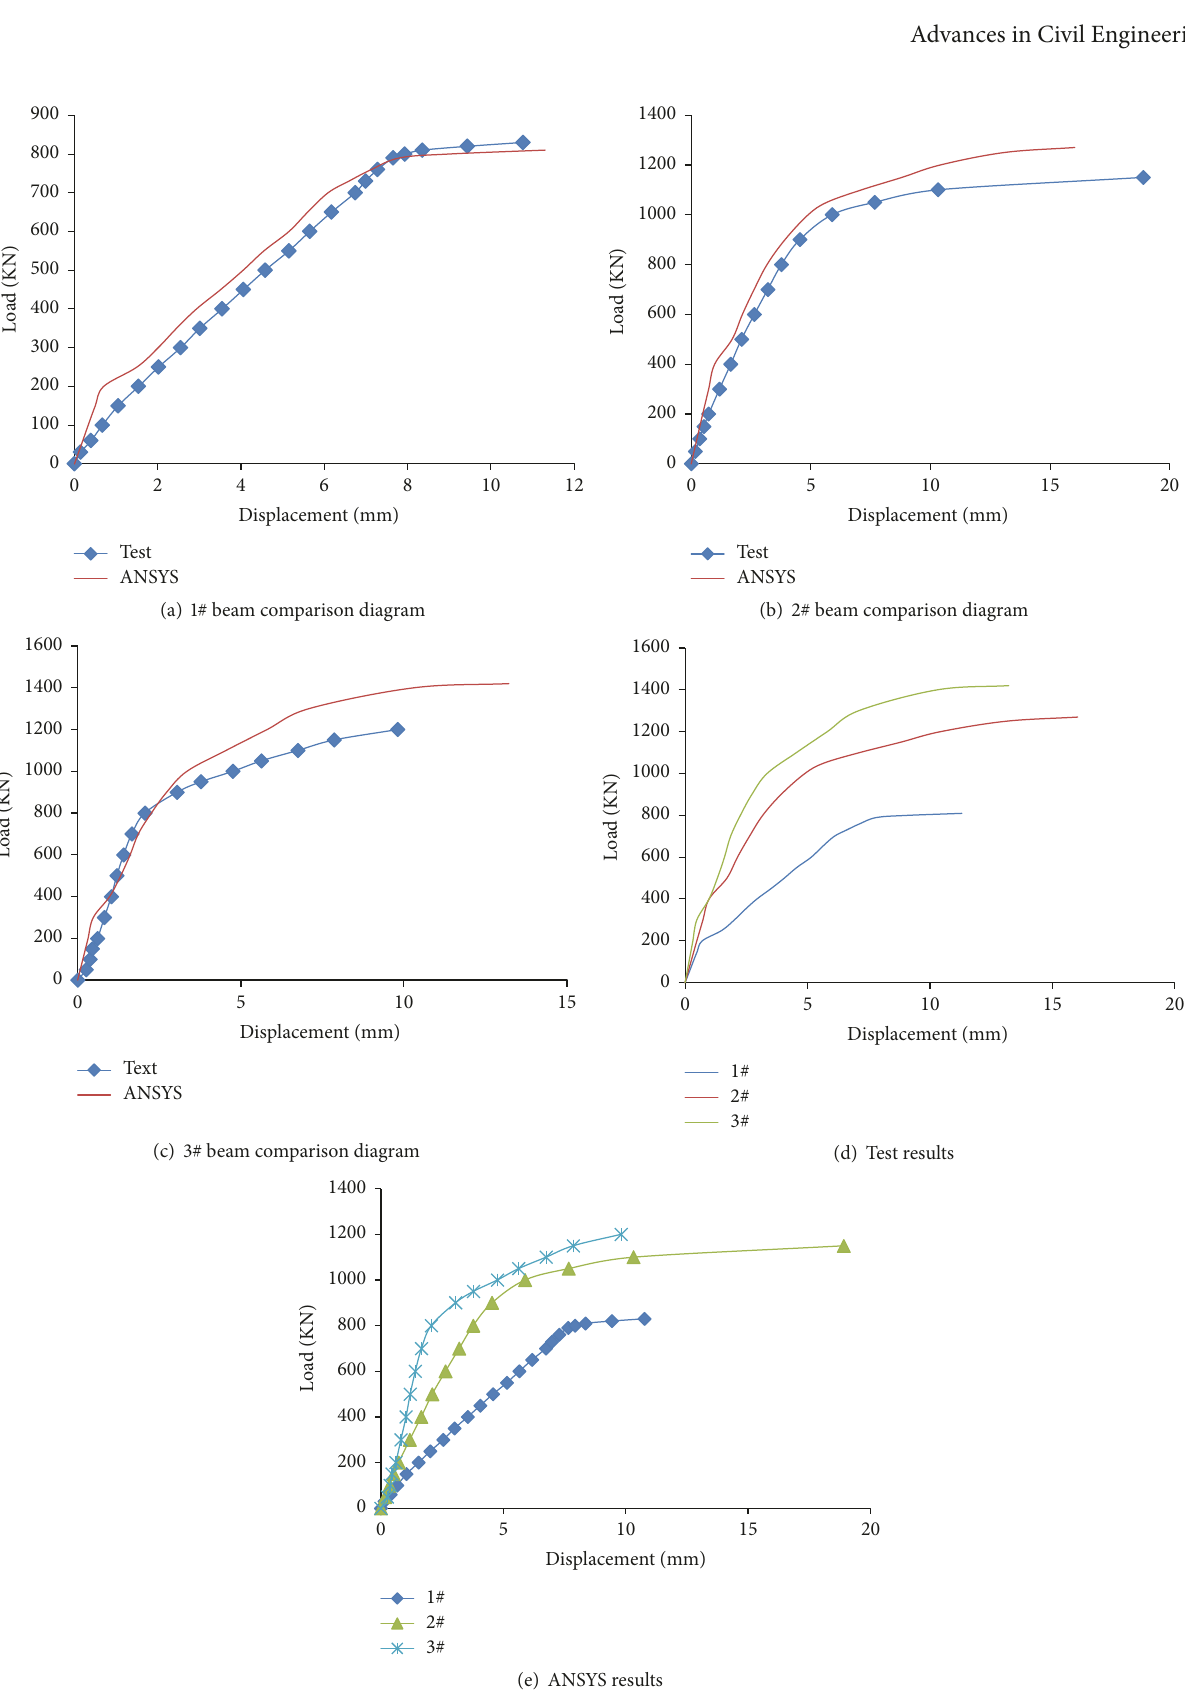
Figure 5: Comparison of the results of test with ANSYS